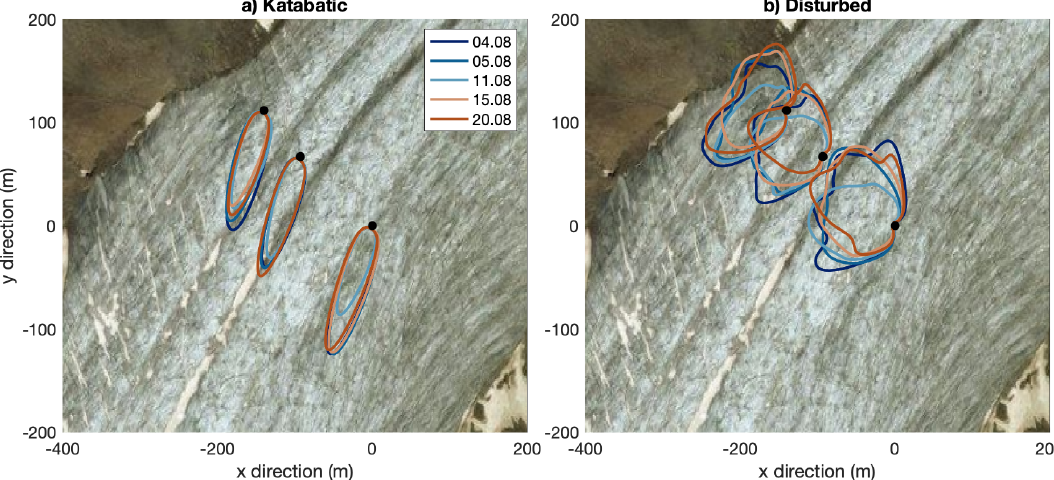
Figure 5. Climatological flux footprints for transect stations TT1–TT3 and for (a) katabatic and (b) disturbed conditions. Background images: ©Microsoft Bing™ Maps; arial screen shot(s) reprinted with permission from the Microsoft Corporation. Measurement days correspond to days